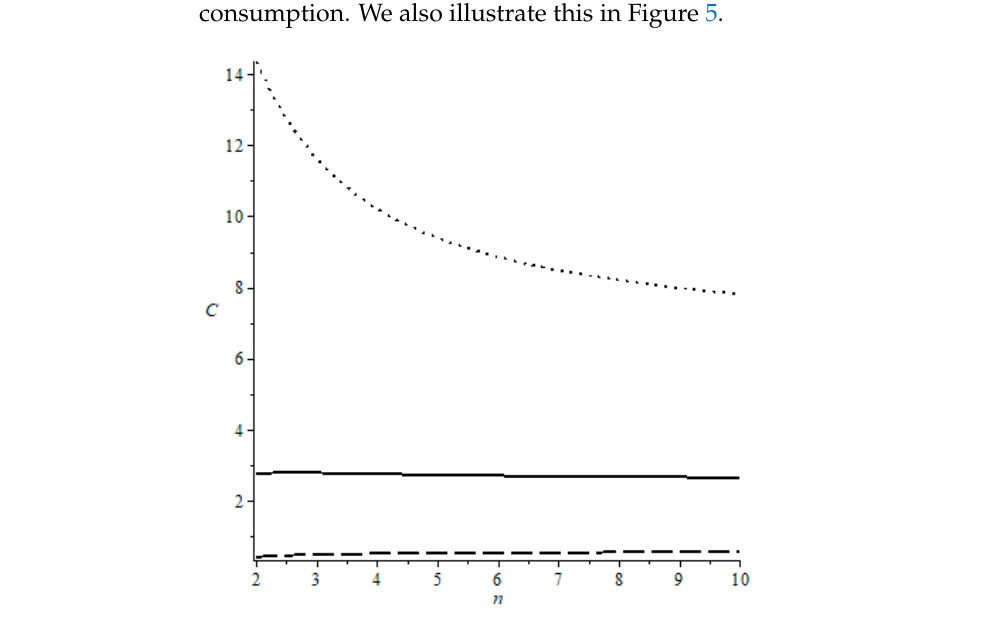
Figure 5. To calibrate the graphs, we used a log-linear utility function and a Cobb–Douglas production function with the following parameter values: q = 0.8, A = 20, β = 0.009, and α = 0.65 (dotted line); α = 0.3 (dashed line); and α = 0.53 (solid